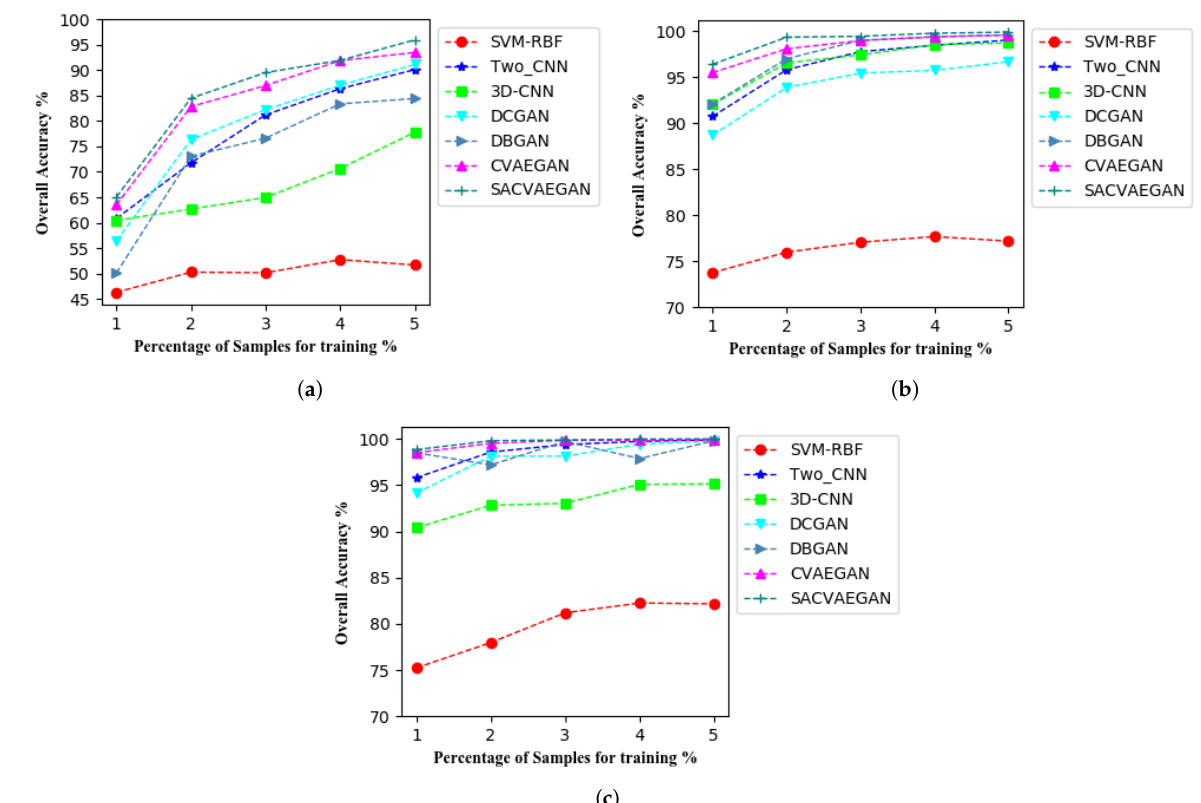
Figure 9. OA(%) of different methods with different training percentages of samples. ( a ) Indian Pines. ( b ) PaviaU. ( c ) Salinas.